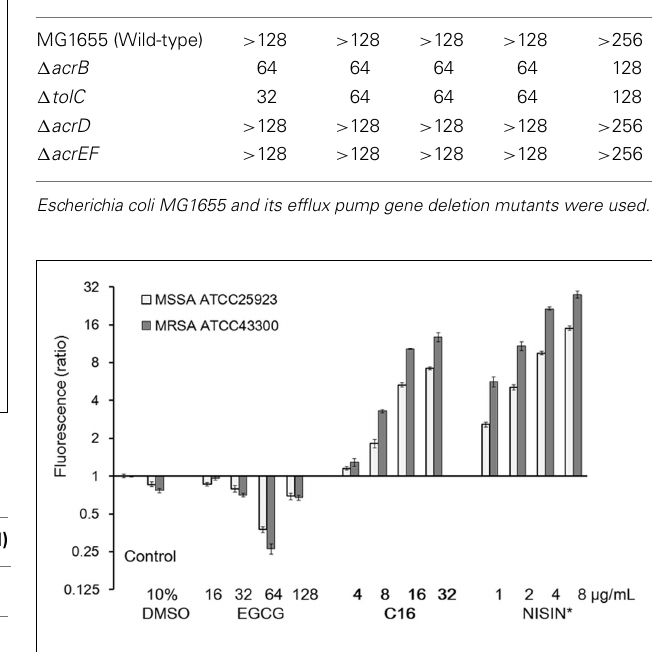
FIGURE 6 | Membrane damage caused by C16 determined by SYTOX Green uptake assay. Fluorescence was determined (Ex/Em: 504/523nm) after 10min incubation with SYTOX Green in a black 384-well plate using a microplate reader after incubation with the antimicrobial compound for 15min. Fluorescence is shown as a ratio to that of control. Data represent Mean ∓ SD ( n = 3). *A polycyclic antibacterial